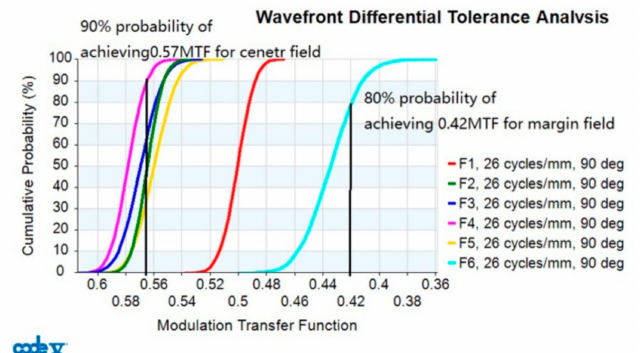
Figure 9. Tolerance curve of freeform lens.